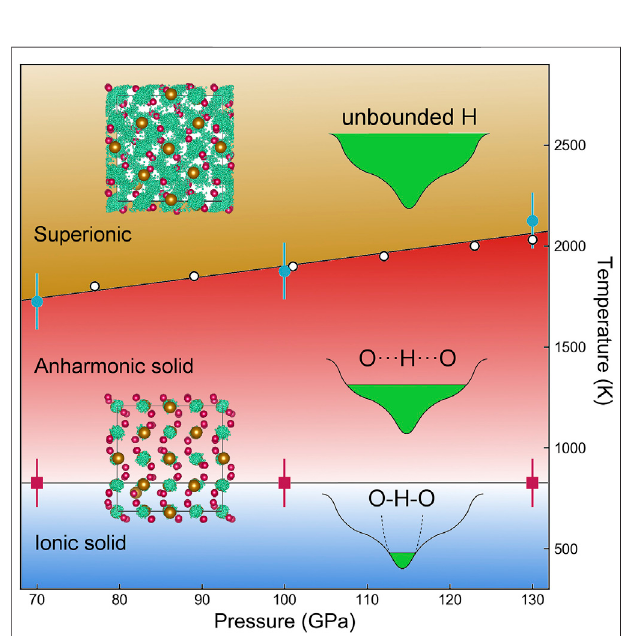
FIGURE 4 | Phase diagram of FeO 2 H on the basis of the motion of hydrogen bond. Open circles are based on the mean-square displacement of H in our previous work (Hou et al., 2021). Solidsquares are on thebasisof the NMR peak